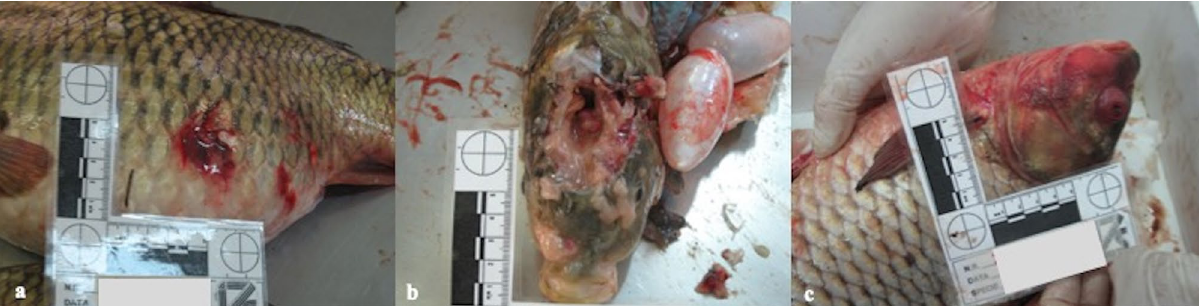
Figure 1. Main gross lesions. ( a ) Multifocal moderate cutaneous hemorrhages, skin of the ventro-lateral part of the body, common carp. ( b ) Diffuse mild to moderate meningeal hyperemia, brain, common carp. ( c )